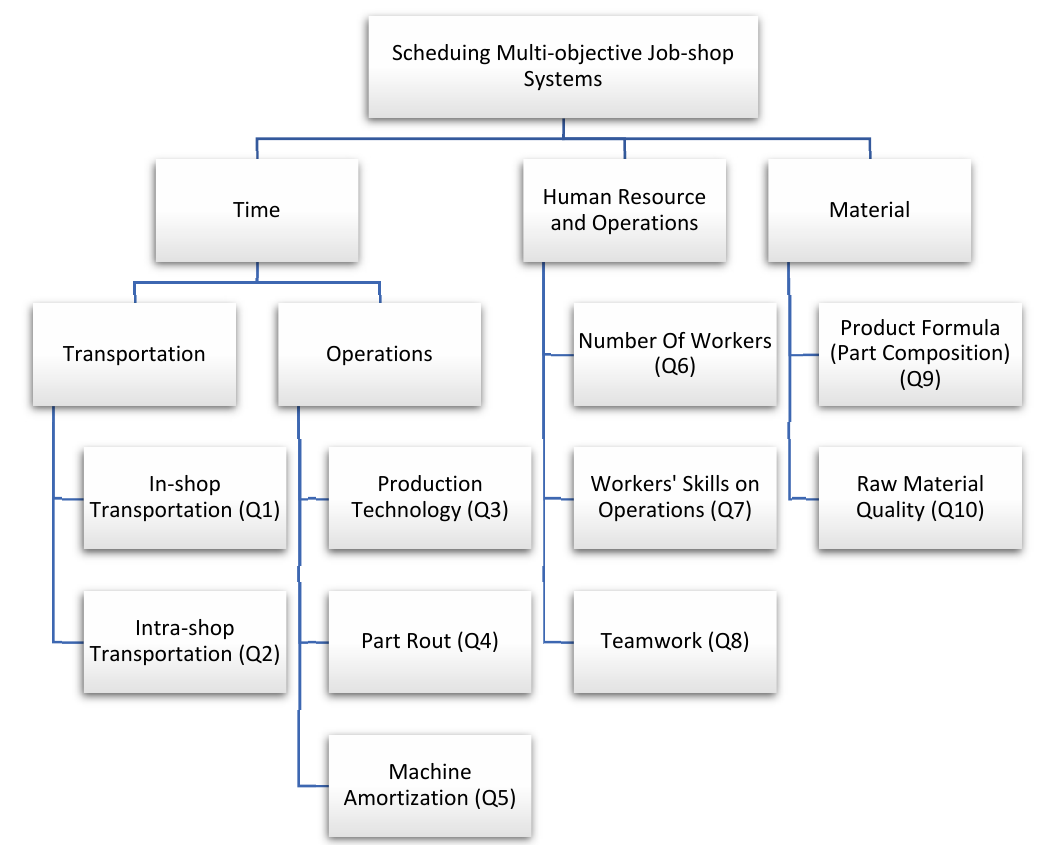
Figure 2. Influential factors on the scheduling of multi-objective job-shop systems.